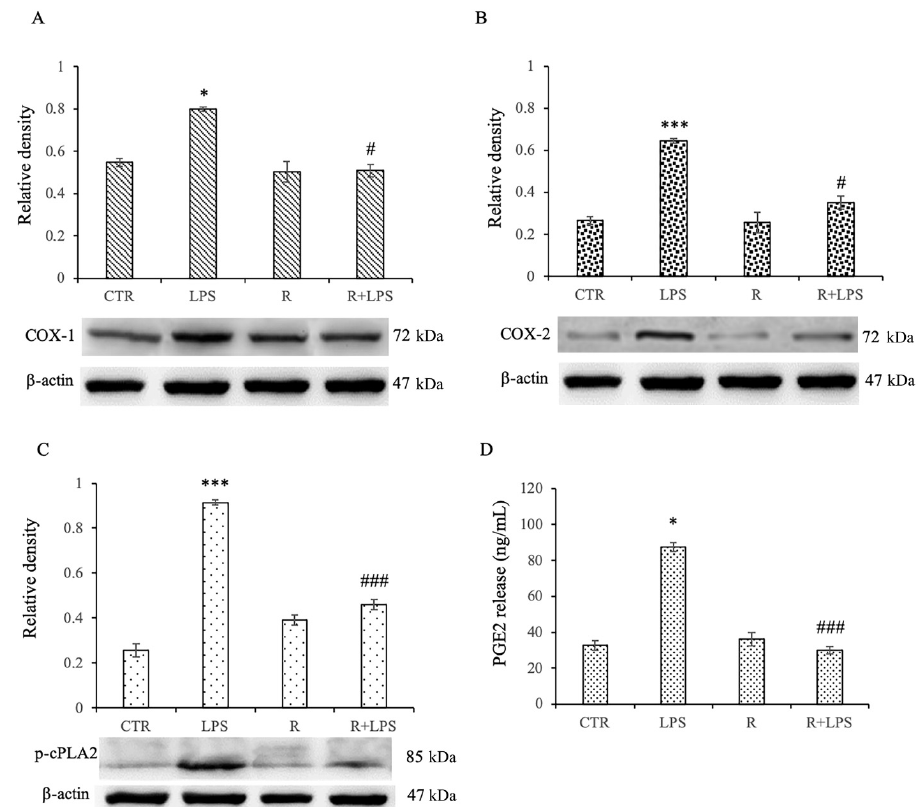
Figure 5. Effects of resveratrol on COX1, COX2, p-cPLA2, and PGE 2 levels in response to 100 ng/mL LPS in N13 microglial cells. Densitometric analysis and immunoblots of COX-1 ( A ), COX-2 ( B ), and p-cPLA2 ( C ) expression levels in microglial cells. ( D ) PGE 2 production by N13 cells pre-incubated in medium containing 10 µ g/mL of resveratrol for 1 h and then treated with LPS (100 ng/mL) for 72 h. Production of PGE 2 was detected using an enzyme immunoassay in unstimulated cells (CTR); in microglial cells treated with LPS or resveratrol (R) alone; N13 cells pre-treated with resveratrol before LPS stimulation (R + LPS). Protein expression levels were normalized to β -actin, and values obtained from densitometric analysis are expressed as means ± SD of five independent experiments. * p < 0.05 LPS vs. CTR, *** p < 0.001 LPS vs. CTR, # p < 0.05 R + LPS vs. LPS, ### p < 0.001 R + LPS vs.